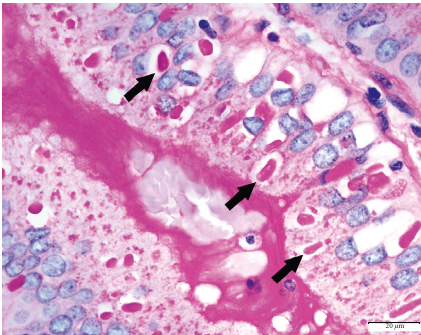
Figure 2: Donor gallbladder, periodic acid–Schiff stain with di- astase (PAS/d), 1000x. Although not required for diagnosis, the parasites can be highlighted by a PAS/d special stain